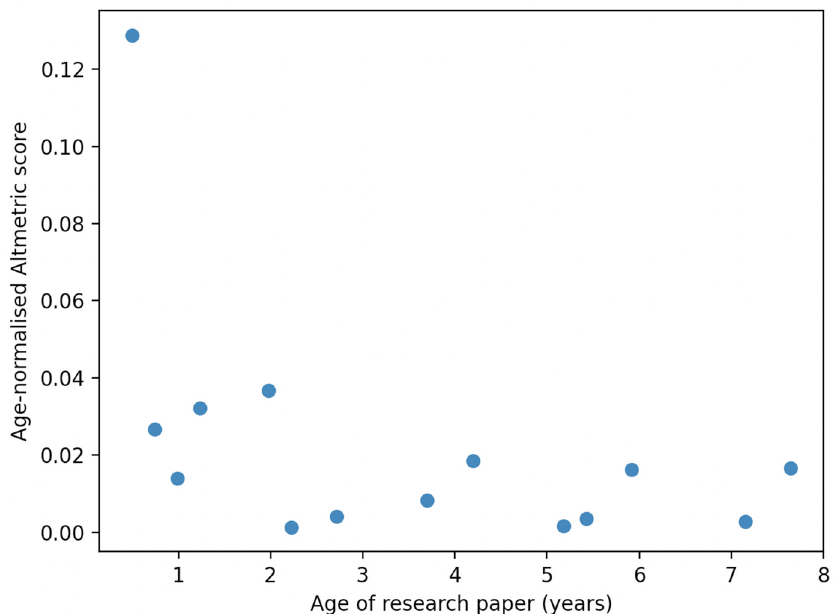
Figure A9. Research papers associated with JOHD/RDJ data papers: average Altmetric scores over time (3-month ranges).